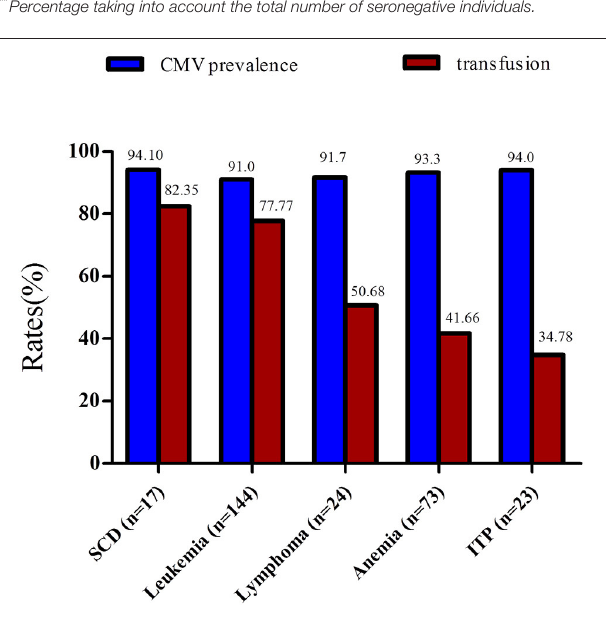
FIGURE 1 | Rates of CMV prevalence and blood transfusions among patients with hematological diseases. All patients subject to this analysis were submitted to more than one blood transfusion during a 1-year period. ITP, immune thrombocytopenic purpura.